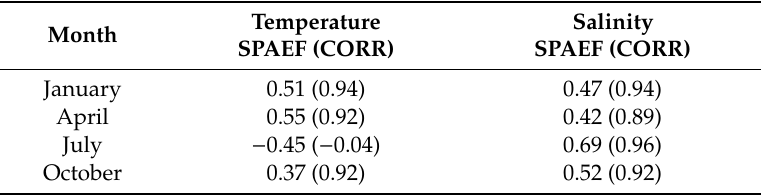
Table 4. Visual performance of the